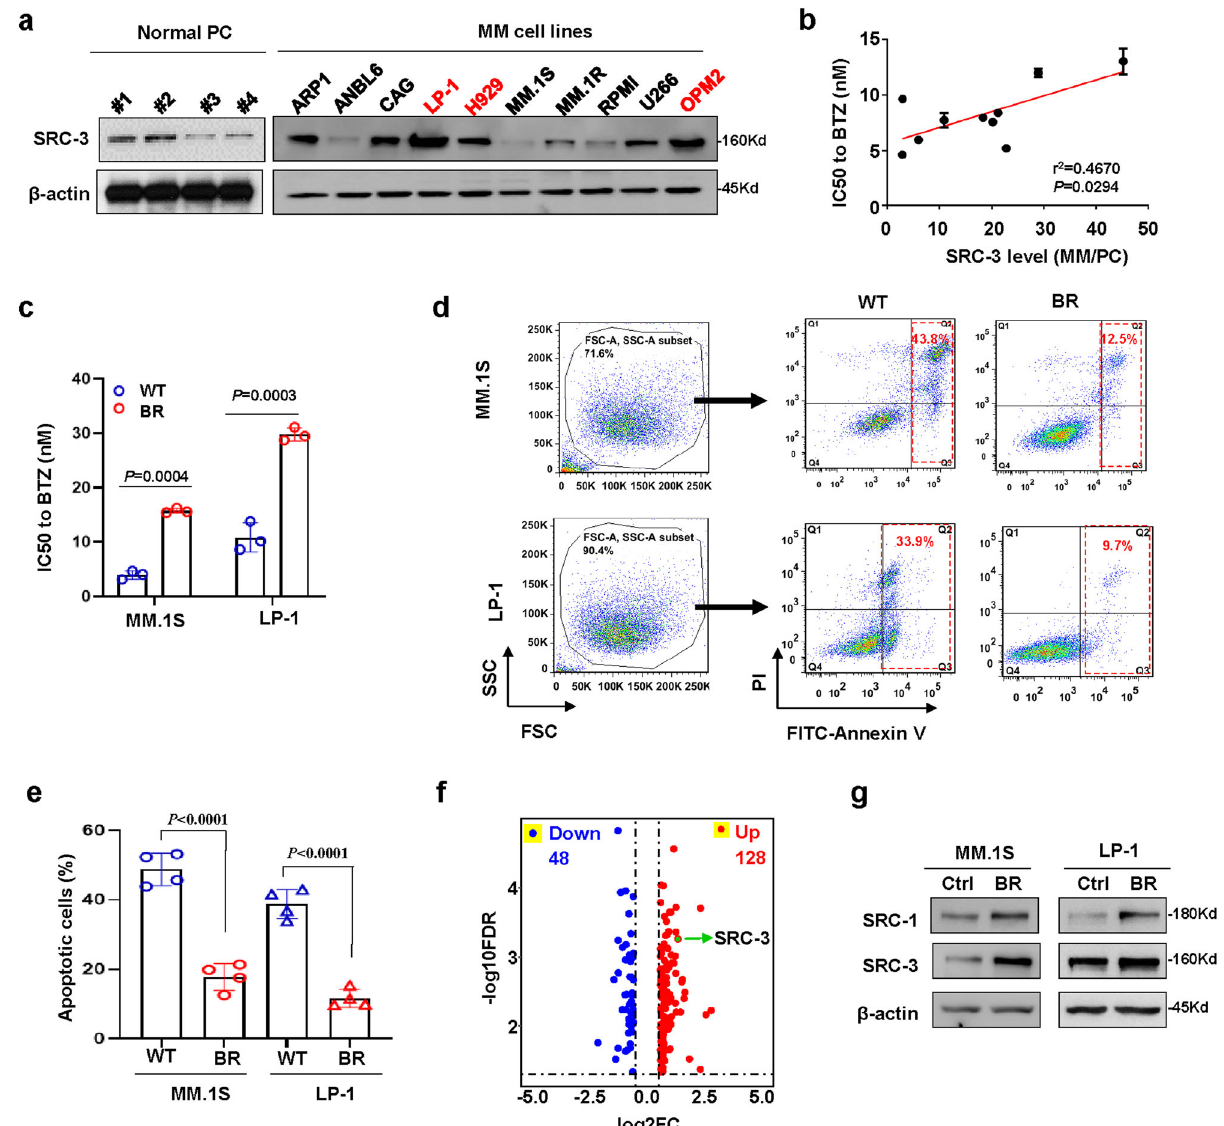
Fig. 2 SRC-3 enhances drug resistance to proteasome inhibitor in myeloma cells. a Representative images ( n = 3 biologically independent experiments) of Western blotting show SRC-3 levels in myeloma cell lines ( n = 10) and plasma cells (PC, n = 4) from healthy controls. Red, cytogenetic t(4;14) cells. b Correlation coef fi cient between the SRC-3 levels and IC 50 in myeloma cells ( n = 3 independent experiments from n = 10 cell lines). P values of mean ± s.d. were determined by Pearson Coef fi cient. c Alteration of IC 50 in bortezomib (BTZ)-resistant (BR) MM.1S and LP-1 cells compared to the parental wild type (WT) cells ( n = 3 biologically independent experiments). Two-sided P -values were determined by Student ’ s t test; mean ± s.d. d Representative gating strategy of fl ow cytometry and apoptosis assay of the wild type (WT) and bortezomib (BTZ)-resistant (BR) MM cells induced by 5 nM BTZ for 48 h, and ( e ) analyzes the difference between two groups ( n = 4 biologically independent experiments). Two-sided P -values were determined by Student ’ s t test; mean ± s.d. f Shown are 48 downregulated and 128 upregulated proteins (cutoff, 1.5 folds) in the bortezomib (BTZ)-resistant (BR) MM.1S cells compared to the wild type (WT) cells detected by Stable isotope labeling with amino acids in cell culture (SILAC) assay. g Elevated SRC-3 in wild type control (Ctrl) and bortezomib (BTZ)-resistant (BR) MM.1S and LP-1 cells by Western blotting ( n = 3 biologically independent experiments). Source data are provided as a Source Data fi